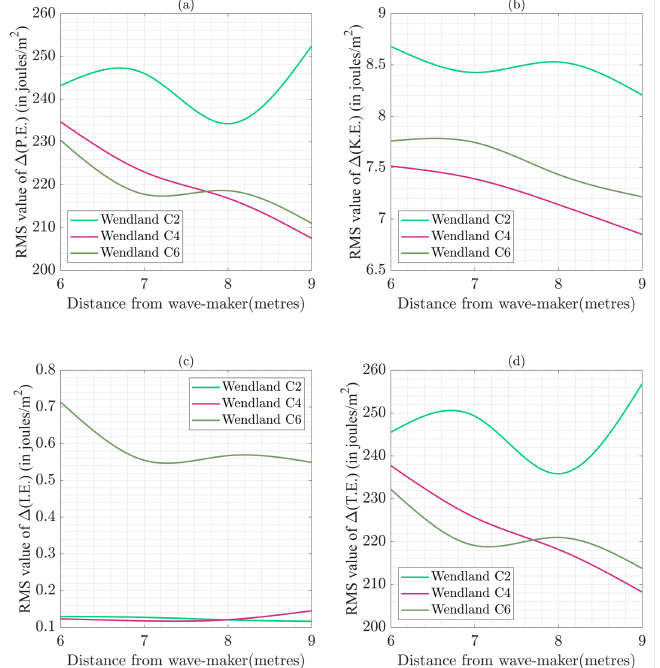
Figure 19. Comparisons of the RMS values at the different probe locations with increasing distance from the wave-maker for the different Wendland kernels: ( a ) potential energy, ( b ) kinetic energy, ( c ) internal energy, and ( d ) total energy.